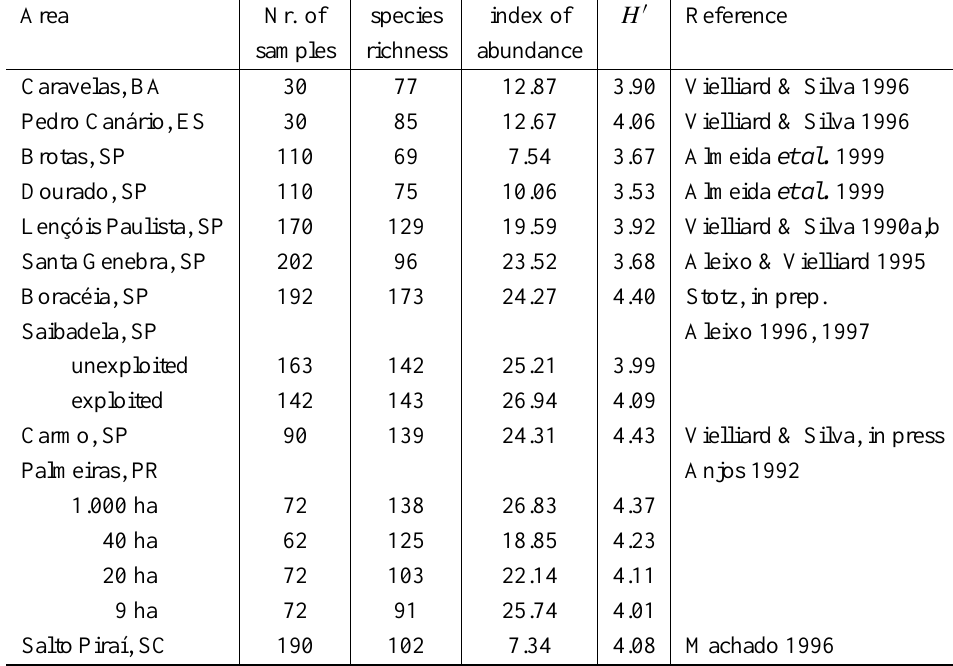
Community parameters of Brazilian Atlantic Forest